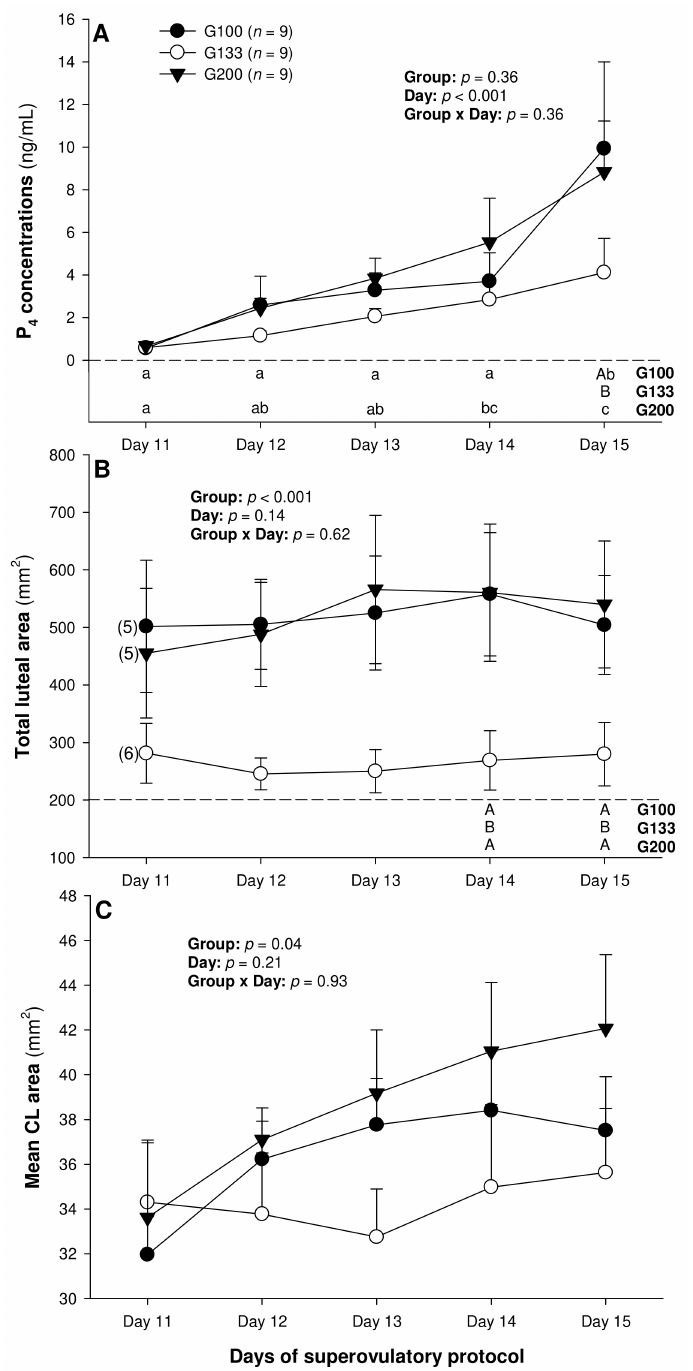
Figure 1. Mean ( ± SEM) serum progesterone (P 4 ) concentrations ( A ) as well as total ( B ) and mean luteal area ( C ) from Day 11 (1 or 2 days after ovulation or beginning of luteogenesis) to Day 15 (day of embryo recovery) of the superovulatory protocol in Santa In ê s ewes superovulated with 100 (G100), 133 (G133), or 200 (G200) mg of pFSH given in eight decreasing doses. Different letters in the lower chart area indicate statistically significant differences: a–c—over time within the treatment groups; AB—between the groups. Numbers in parentheses (panel B ) denote the numbers of ewes in which CL were detectable ultrasonographically on Day